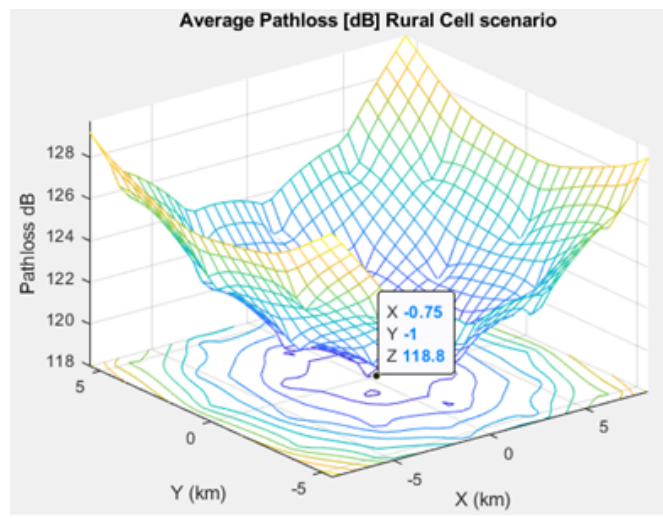
Figure 24. Average path loss in the rural cell